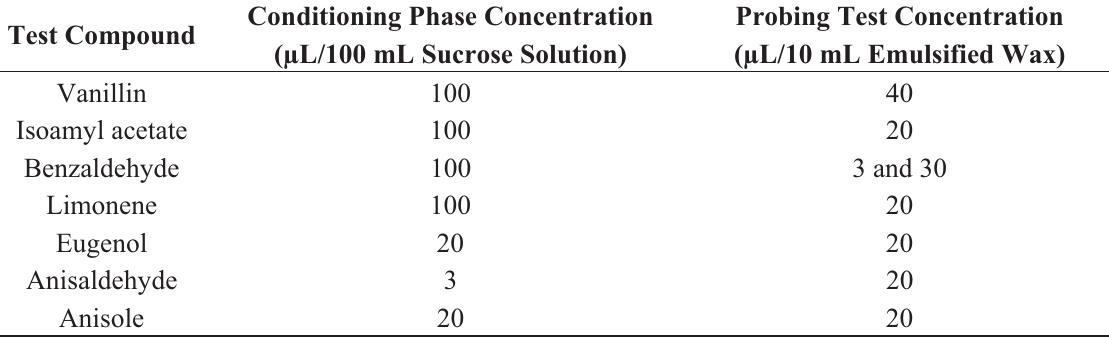
Table 2. Compounds used in associative learning tests, their concentrations used during the conditioning and testing phase of the tests, and their commercial